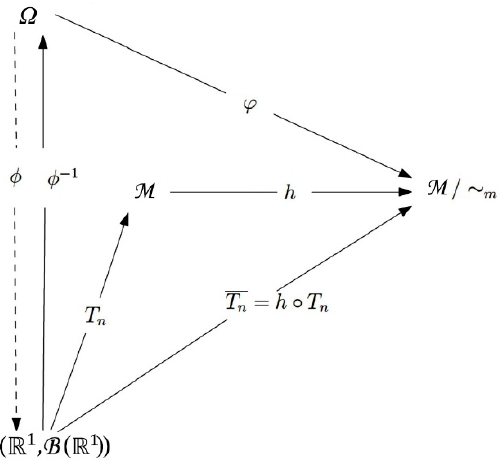
Figure 1. The main idea of the proof of the central limit theorem.